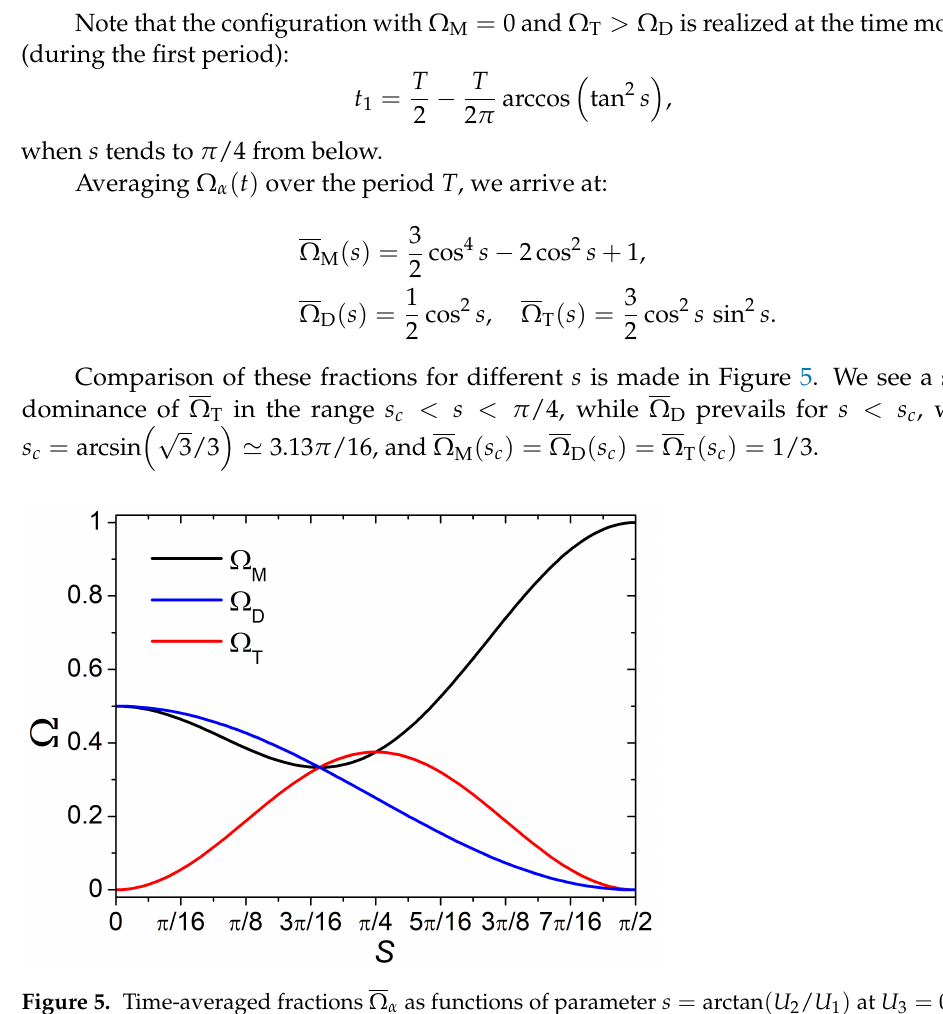
→ λ + µ . Including ˆ H = diag ( 0, − 2 J sinh ( a ) , 0 ) 0 i i